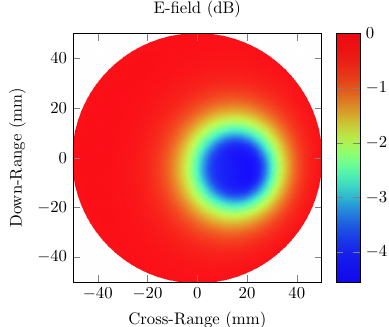
Figure 8. Total electric field intensity distribution of a 434 MHz radio frequency source inside the breast phantom. The background has a conductivity σ = 0.0353 S/m and dielectric constant ε r = 5.51. Glandular tissue ( σ = 8.86 S/m, ε r = 61.3) surrounds a tumor ( σ = 13.03 S/m, ε r = 25.25) located 32.5 mm deep from the right side of the phantom.